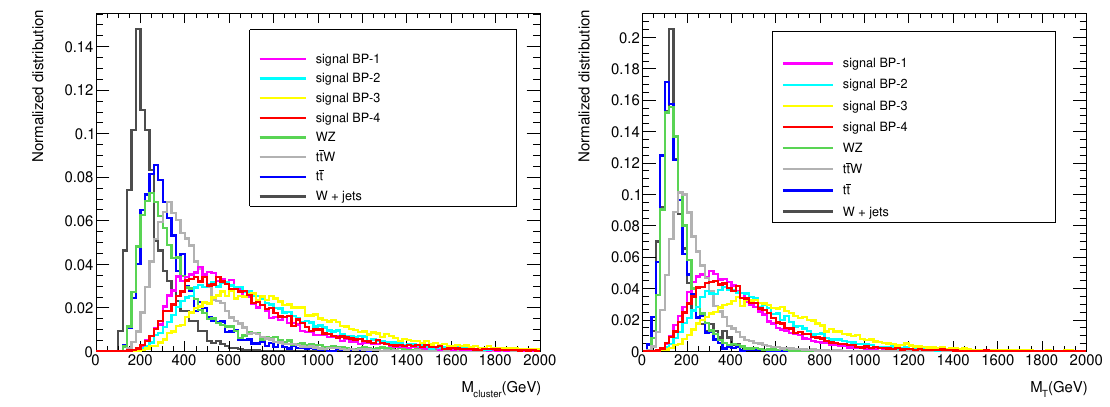
Figure 16 . Distribution of cluster transverse mass(left) and transverse mass(right) for the four signal BPs and backgrounds in case II.